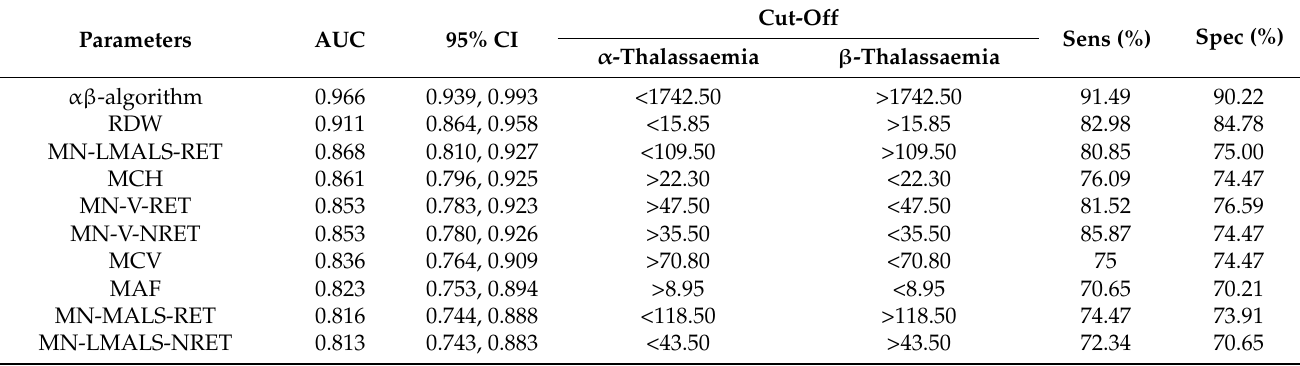
Table 2. The ROC data elaboration for each reticulocyte CPD to distinguish α from β -thalassaemia. Parameters